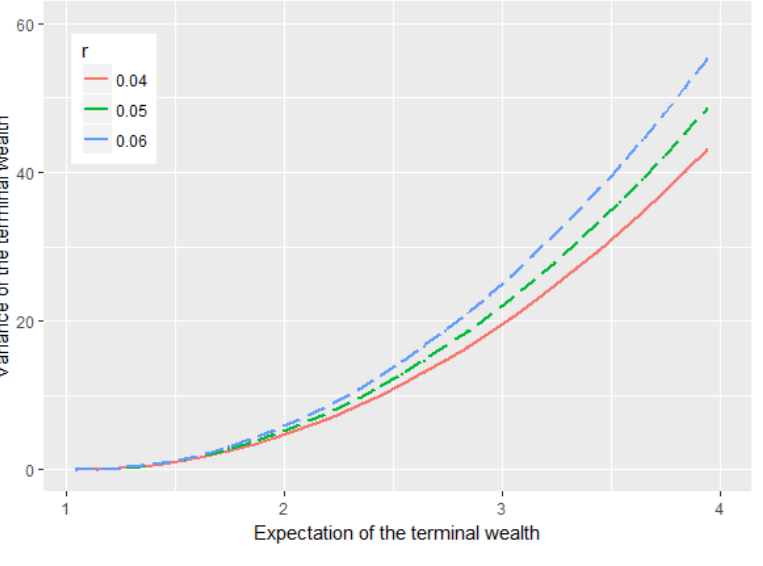
Figure 1. The impact of r on the efficient